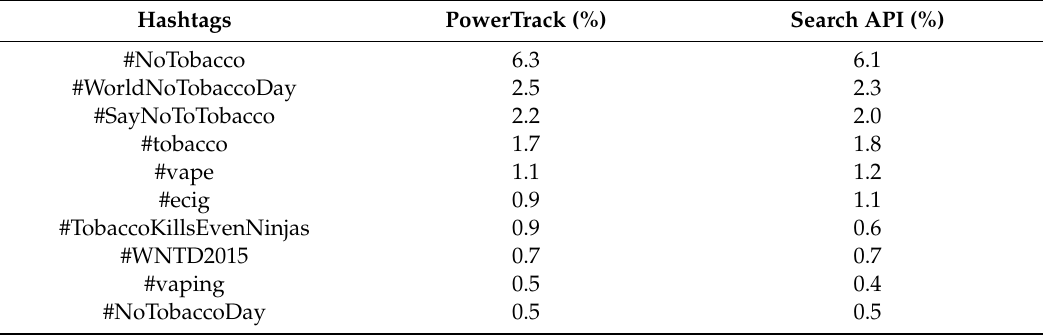
Table 1. Top hashtags of tobacco-related tweets on World No Tobacco